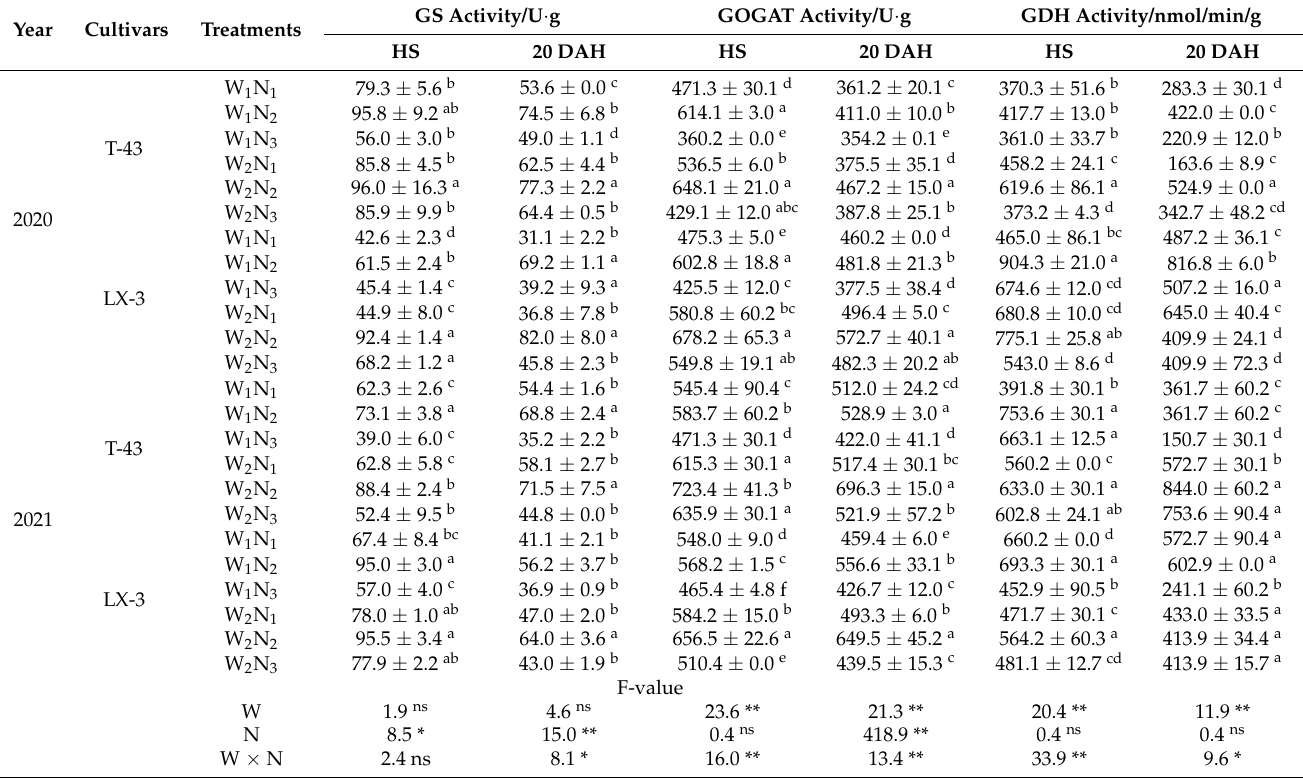
Table 6. Effects of water and nitrogen management on nitrogen metabolism enzyme activities in rice leaves under drip